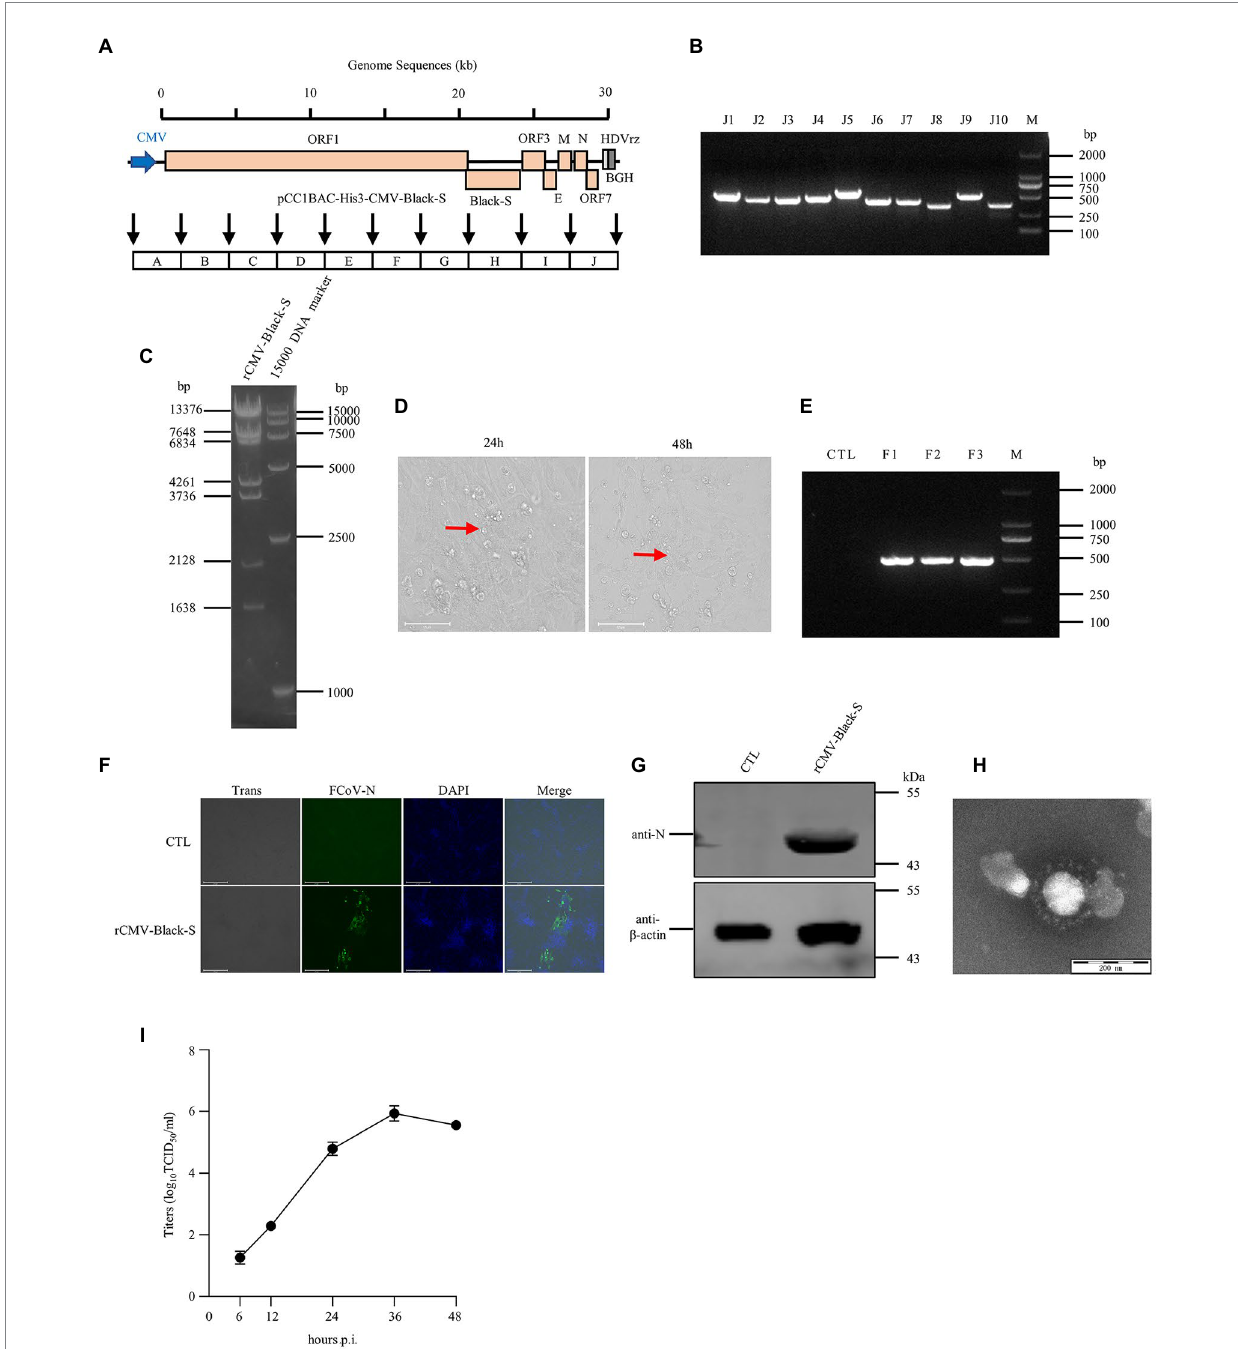
FIGURE 5 The recovery and identification of culture-adapted wild-type I FIPV Black strain. (A) Strategy diagram for the construction of pCC1BAC-His3-CMV-Black-S. (B) Identification of fragment interfaces of the plasmid recovered from bacteria. (C) Restriction enzyme digestion of the positive plasmid ( Nco I) purified from E. coli. (D) Significant cytopathic effects (CPE) were observed at 24 and 48 h after infection with FCWF-4 cells. (E) PCR identification of the rescued virus. (F) and (G) rCMV-Black-S virus infected FCWF-4 cells for 12 h was identified by IFA (Scale Bar, 275 μ m) and WB. Electron microscopy of the purified virus. (H) Electron microscopy examination of the purified virus. (I) Growth curve of rescued rCMV-Black-S virus on FCWF-4 cells with original MOI of